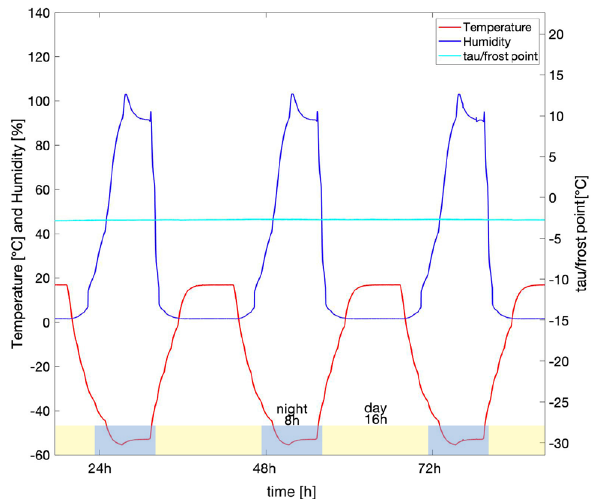
Figure 3. An instance over three days of the Mars-like diurnal cycle profile of temperature (red line) and relative humidity (blue line). The cyan line indicates the frost point